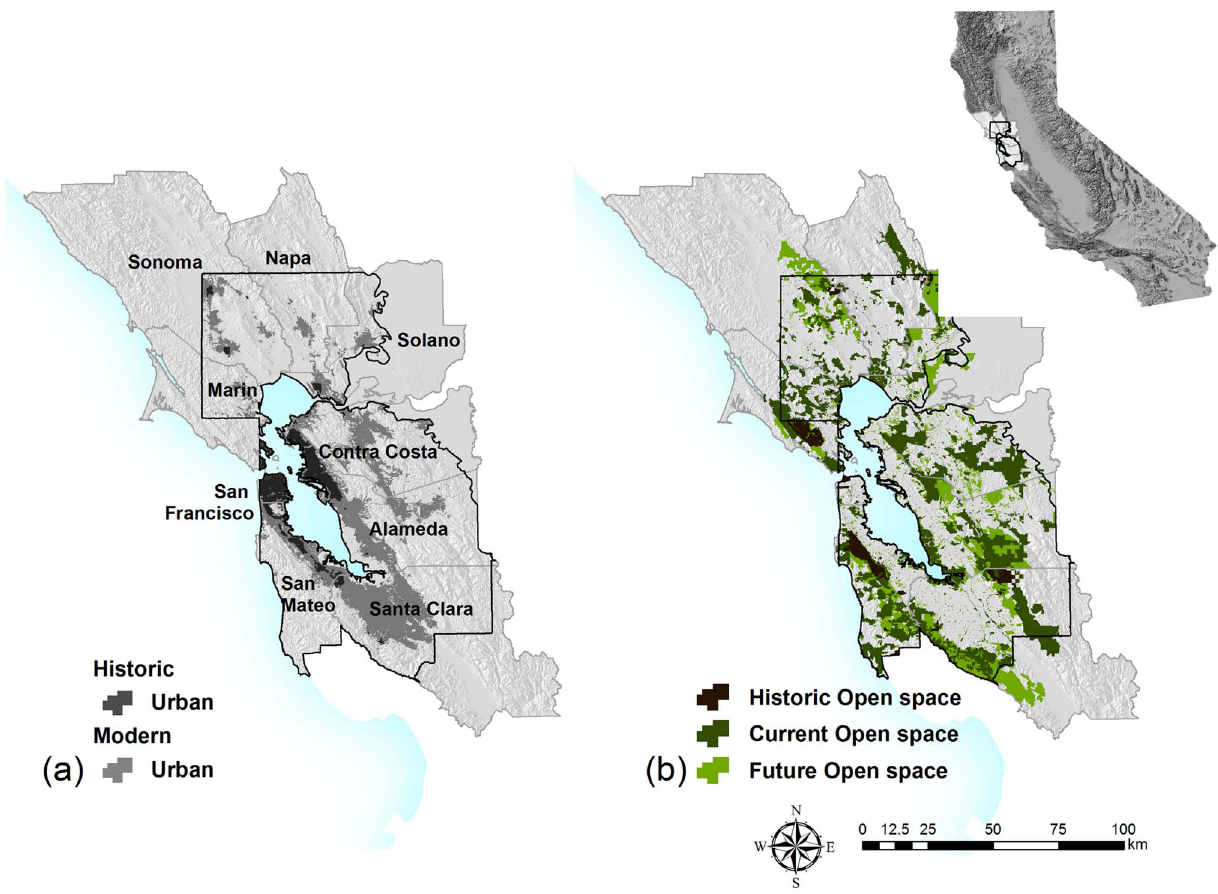
Figure 1. The San Francisco Bay Area, (a) including historic and current urban areas for Alameda, Contra Costa, Marin, Napa, San Francisco, San Mateo, Santa Clara, Solano, and Sonoma counties in California, USA; (b) historic, modern and future Open Space in the study area. The extent of this study is limited to 9275 km 2 that were surveyed by the historic landcover mapping effort (inside the dark line).